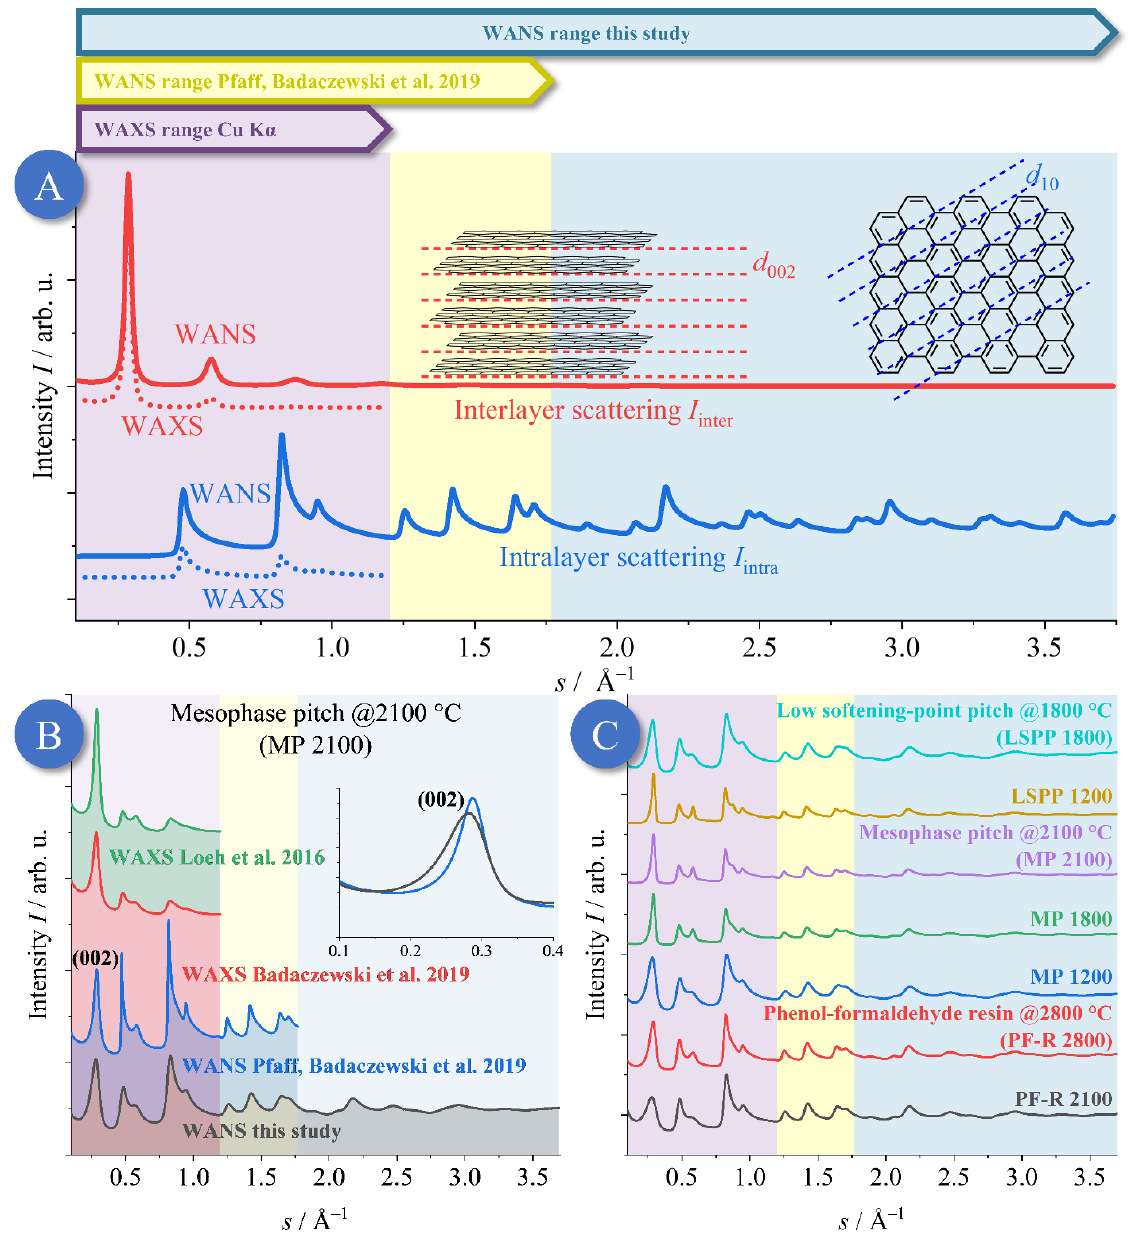
Figure 2. ( A ): Simulation of WAXS/WANS data of a representative NGC (without background scattering), which is given by a superposition of symmetric interlayer reflections (00 l ) and asymmetric intralayer reflections ( hk ). By using neutron radiation instead of X-rays, much more intralayer reflections can be measured, and, therefore, the intralayer graphene structure in particular can be determined more accurately. ( B ): One particular sample (mesophase pitch; MP @2100 °C, i.e., treated at 2100 °C) was studied four times, namely using WAXS measurements in the study of Loeh et al. (2016) [40], WAXS measurements in the work of Badaczewski et al. (2019) [37], WANS analysis performed by Pfaff et al. (2019) [43], and WANS measurements, the latter of which were performed in this study. In the present WANS study, a much lower wavelength was used compared to Badaczewski et al. (2019) [43]. While both WAXS measurements are very similar, there are differences between the two WANS measurements (performed at the Berlin and Grenoble facilities) due to the different instrumental resolutions. ( C ): Overview of the WANS data of samples, which were measured two times (2019 and in this study) and combined to get one merged WANS curve with high s -space resolution, and also an extended s -range. Here, s means the modulus of the scattering vector s ( s = 2 sin( θ )/ λ ). It should be noted that the indexing shown with parentheses strictly denotes lattice planes, and reflections would have to be indexed without parentheses. However, brackets are used in this publication for both meanings to improve readability.